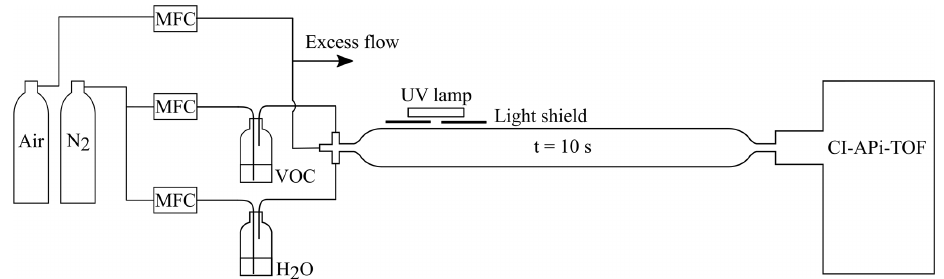
Figure 1. Flow reactor set-up used at the University of Helsinki. The aromatic VOC and water vapour were mixed with synthetic air at the inlet of the flow reactor. A shielded UV lamp irradiated a small part of the reactor, forming OH radicals by photolysing the water vapour. The inlet flow to the CI-APi-TOF mass spectrometer (see Sect. 3.2.1) defined the residence time ( ∼ 10s) in the reactor.